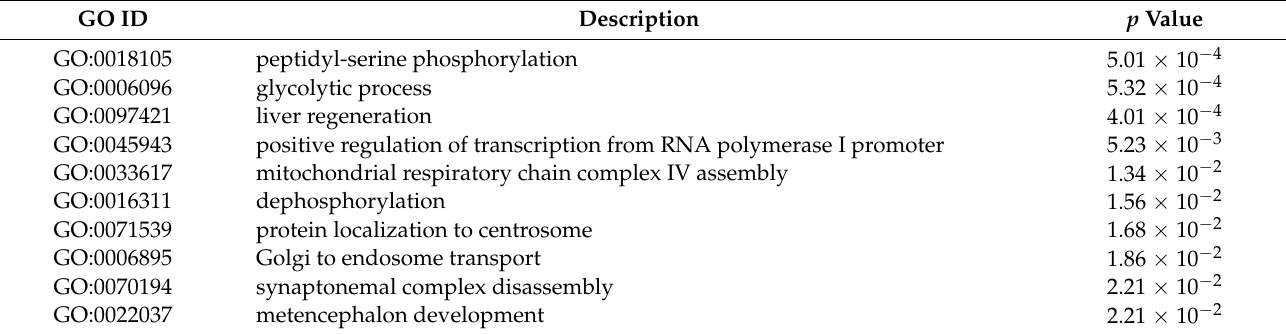
Figure 3. MA plots of proteomic analysis results. ( a ) Plot of all quantified proteins. ( b ) Magnified view of the plot ( a ) in the range of |log 2 FC| ≤ 2. Table 2. The top 10 gene ontology (GO) terms that were enriched in the tubular liver tissue.